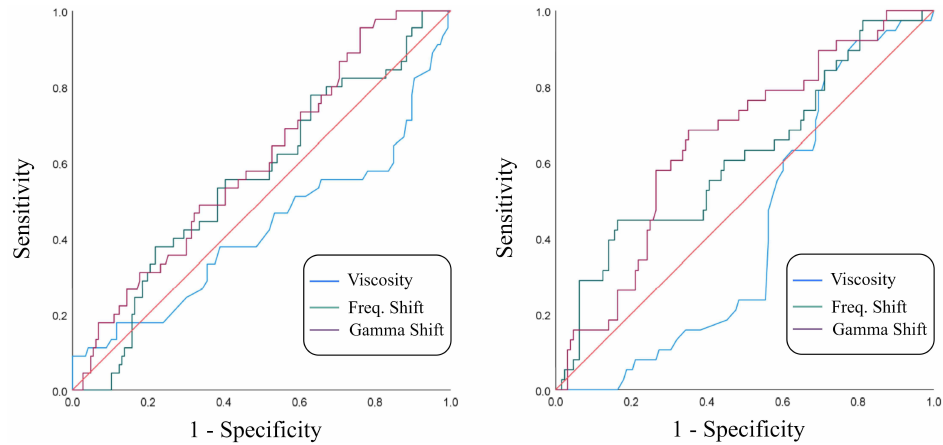
Figure 5. ROC curves for parameters measured with the sensor for: SF in tubes with EDTA ( left ) and